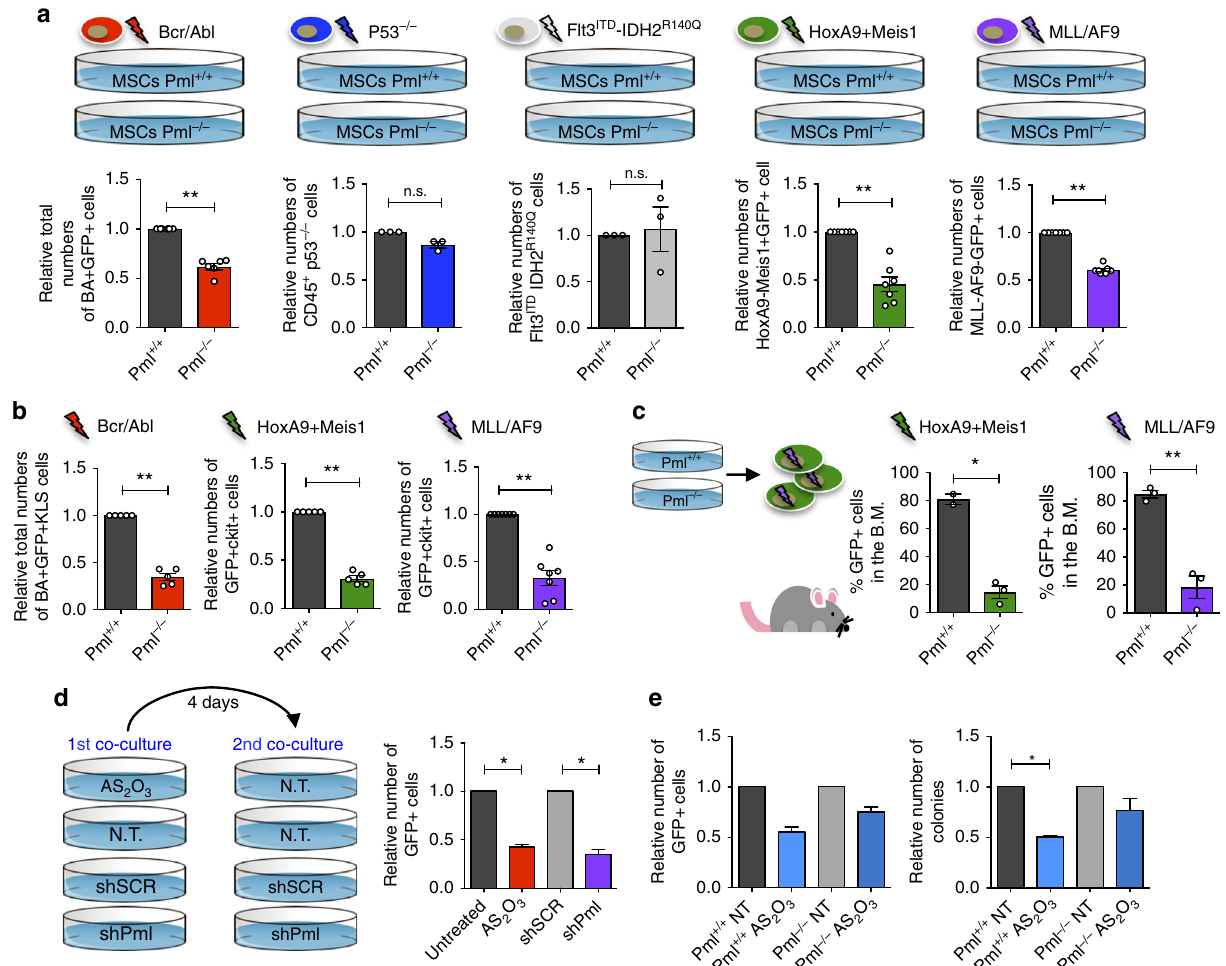
Fig. 3 Pml regulates leukemic cells in a non-cell-autonomous manner. a Relative number of leukemic cells with different genetic background in serial co- culture with MSCs Pml +/+ or Pml − / − ( n ≥ 3 biological replicates). Charts represent mean ± SEM. b Relative total number of BA + GFP + KLS cells, GFP + ckit + Hoxa9 + Meis1 cells, and GFP + ckit + MLL/AF9 cells in serial co-culture with MSCs Pml +/+ or Pml − / − ( n ≥ 5 biological replicates). Charts represent mean ± SEM. c Schematic representation of the experimental design is depicted on the left. Leukemic cells were derived from the last co-cultures and transplanted into recipient wild-type mice. Chart on the left shows the percentage of GFP + leukemic cells HoxA9 – Meis1 in the bone marrow of recipient mice. Chart on the right shows the percentage of GFP + leukemic cells MLL/AF9 in the bone marrow of recipient mice ( n ≥ 2 mice). Charts represent mean ± SEM. d Schematic representation of the co-culture assays between MSCs untreated or treated with AS 2 O 3 , or MSCs silenced for the expression of Pml with shRNAs, and leukemic cells (each co-culture was carried on for 4 days). The chart on the right shows the relative numbers of GFP + leukemic cells derived from the second co-culture, after the treatment. The chart shows the average of two replicates ± SEM. e Relative number of leukemic cells (GFP + ) in the second co-culture (chart on the left), and relative number of colonies in methyl-cellulose (chart on the right) upon treatment with AS 2 O 3 of Pml +/+ or Pml − / − MSCs. Charts show the average of two replicates ±